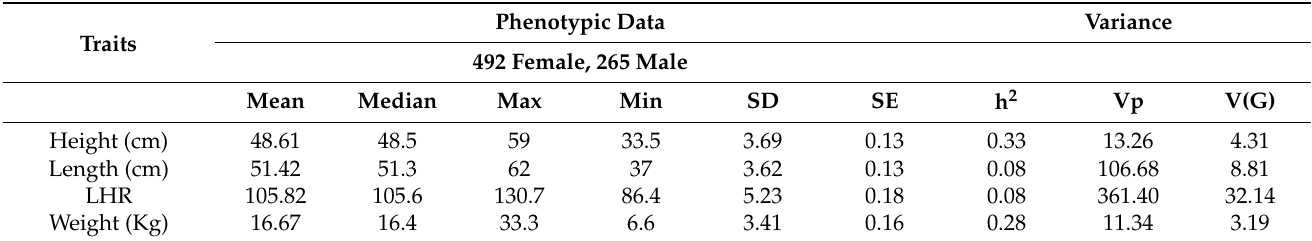
Table 1. Descriptive summary of phenotype data.